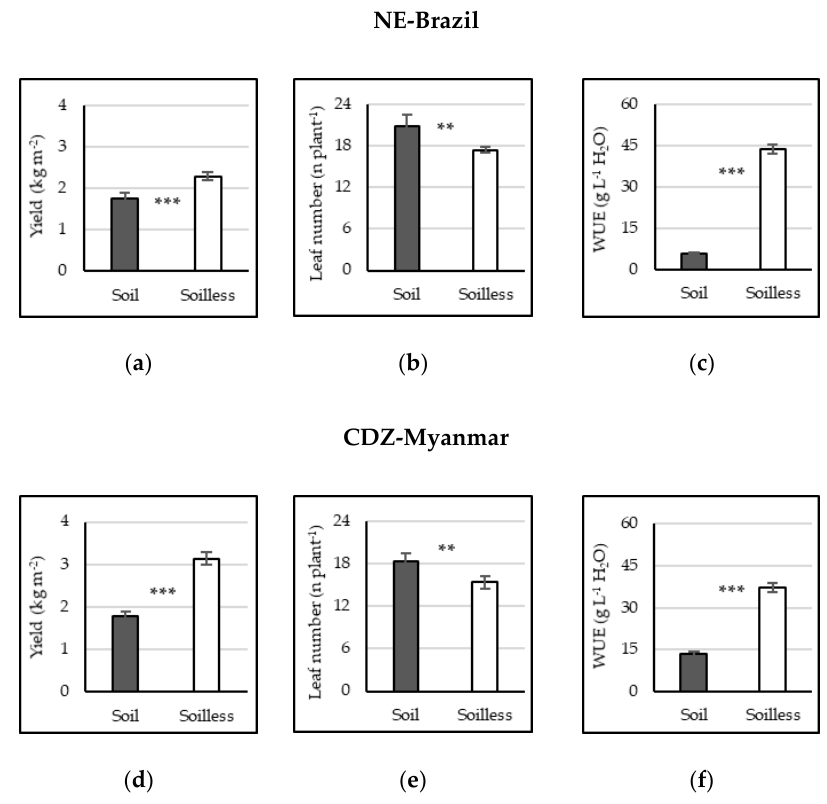
Figure 2. Results from experiments 1 (Brazil, top row) and 2 (Myanmar, bottom row). Lettuce yields ( a , d ), leaf number ( b , e ), and water use e ffi ciency (WUE, c , f ). Vertical bars represent standard errors. ( a , d ), leaf number ( b , e ), and water use efficiency (WUE, c , f ). Vertical bars represent standard errors. Significant di ff erences at p ≤ 0.01 (**), p ≤ 0.001 Significant differences at p ≤ 0.01 (**), p ≤ 0.001 (***).